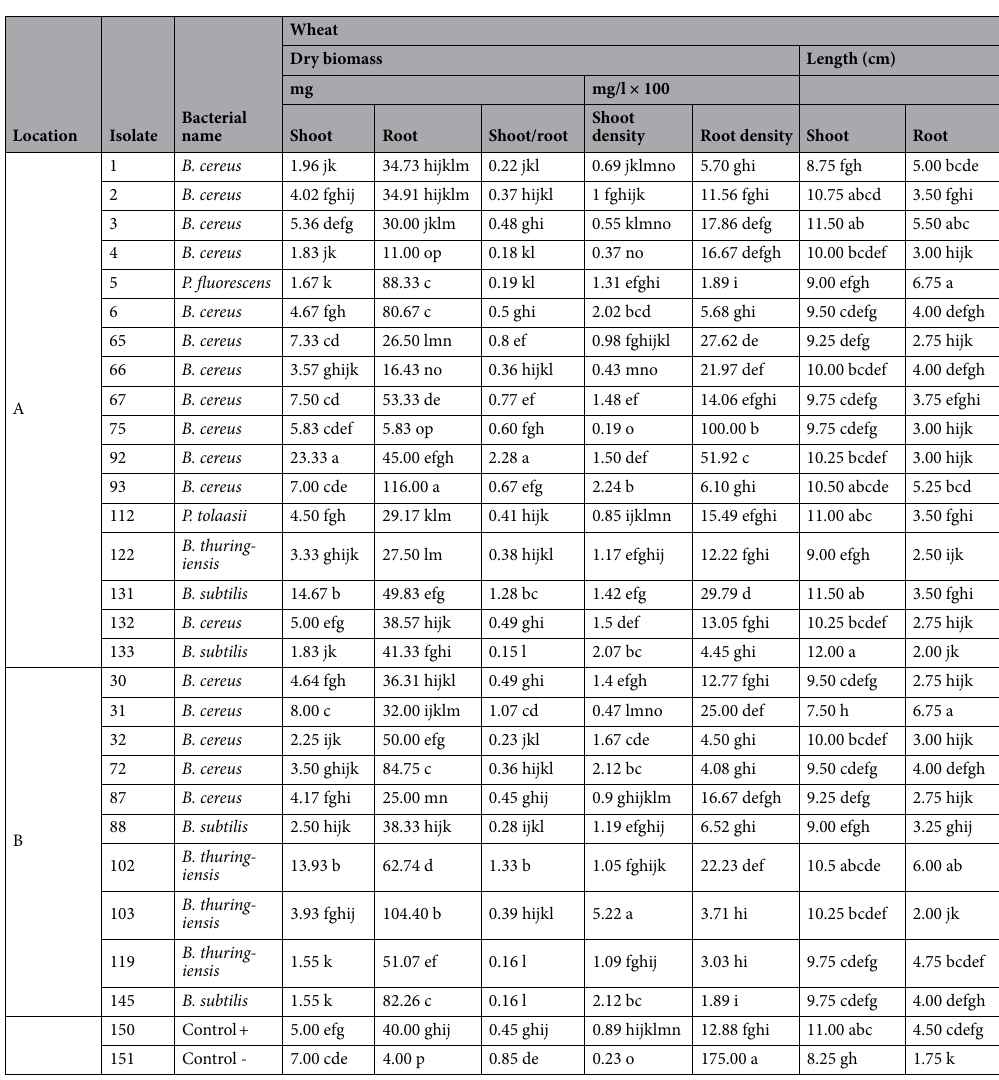
Table 4. Influence of soil isolates on growth parameters after 21 days of assessment on wheat plants. LSD p = 0.01 value for the parameters on wheat, respectively: 0.003243491, 0.05366804, 0.05586241, 0.1312794, 3.136652, 2.177158, 4.041771; A and B were indicated sampling